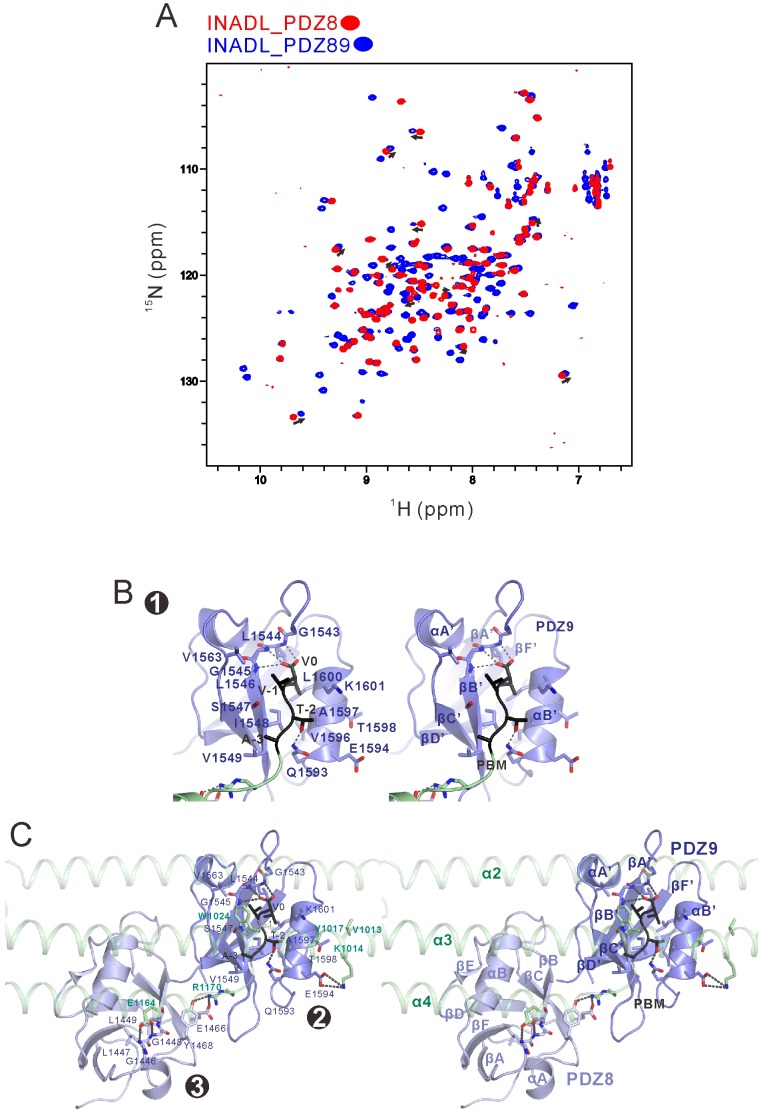
Detailed analysis of the interaction between INADL PDZ89 and the PLCβ4 CC-PBM.(A) Overlay plot of the 1H-15N HSQC spectra of INADL PDZ8 (in red) and PDZ89 (in blue), showing that a subset of peaks from PDZ89 nicely overlap with the peaks of isolated PDZ8. This analysis indicates that there is minimal conformational coupling between PDZ8 and PDZ9 in the isolated PDZ89 tandem. (B) Stereoviews showing the binding of PLCβ4 PBM (in black) with the canonical PBM binding groove of INADL PDZ9 (in blue). (C) Stereoviews showing the interaction interfaces between INADL PDZ89 and PLCβ4 CC-PBM.